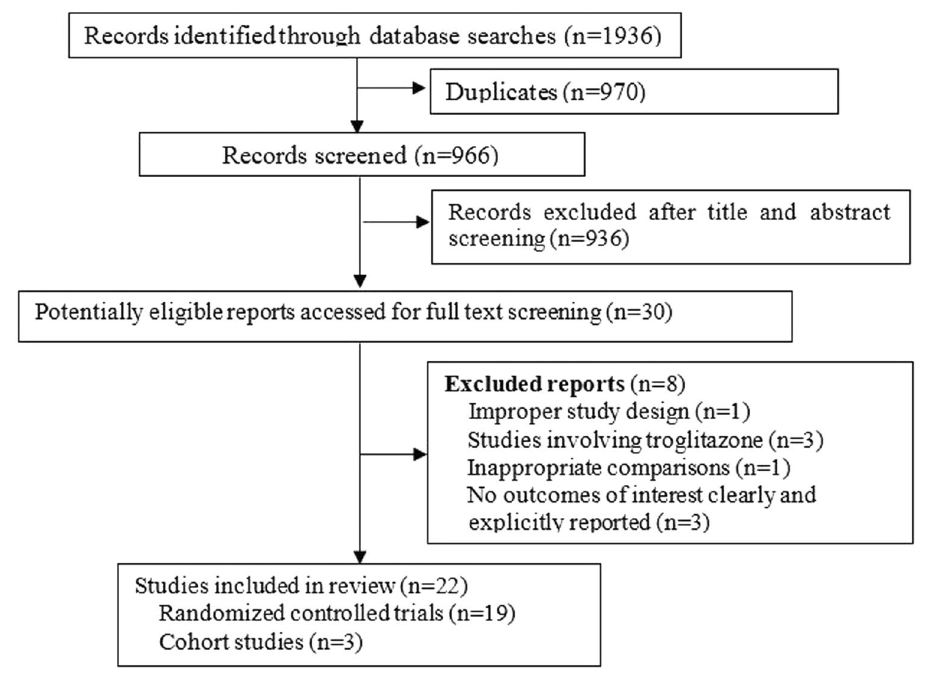
Figure 1. Flow chart of article